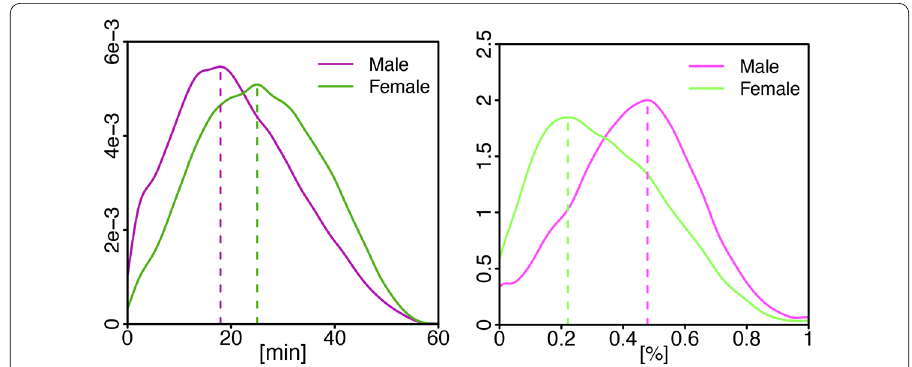
Figure 1 Most discriminative feature in EU (left): the maximum text response delay during the week; in SA (right): percent of calls initiated by the person during the weekend nights. The dashed lines indicate the modes of the distributions, with 25 minutes for females and 18 minutes for males in EU and 22% for females and 48% for males in SA.